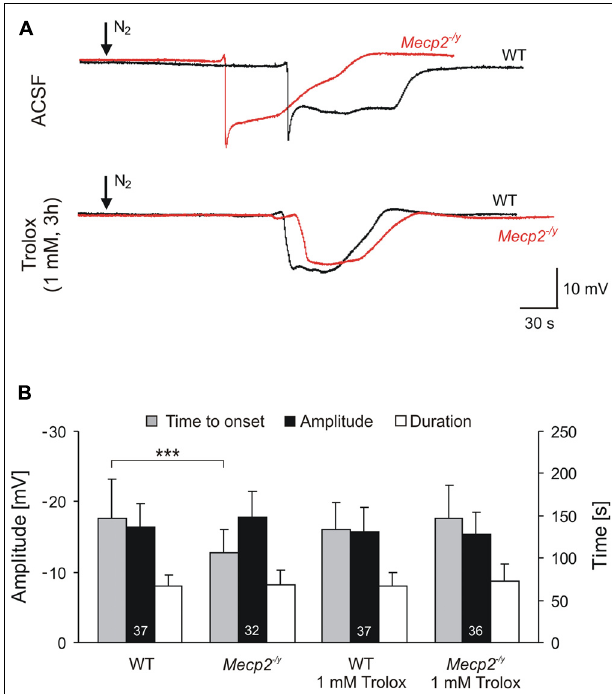
FIGURE 3 |Trolox improves the hypoxia tolerance of Mecp2 − / y hippocampus. (A) Extracellular DC potential deflections associated with HSD. Note that upon O 2 withdrawal, HSD occurs earlier in Mecp2 − / y than inWT slices. Incubation of slices withTrolox (1 mM, 3–5 h) selectively postponed HSD onset in Mecp2 − / y slices to values typically observed in WT.The time point of O 2 withdrawal is indicated by the arrows; oxygenation was restored 30 s upon HSD onset. Recordings were performed in CA1 st. radiatum . (B) Statistical comparison of the characteristic parameters of the HSD-associated DC potential shift, i.e., amplitude of the negative DC shift (plotted versus the left-hand ordinate in mV) as well as its time to onset and duration (both plotted versus the right-hand ordinate in s).Trolox postponed the onset of HSD in Mecp2 − / y slices, but did not affect the other parameters or its properties inWT.The number of slices analyzed is reported; genotypic differences are indicated by asterisks (*** P <